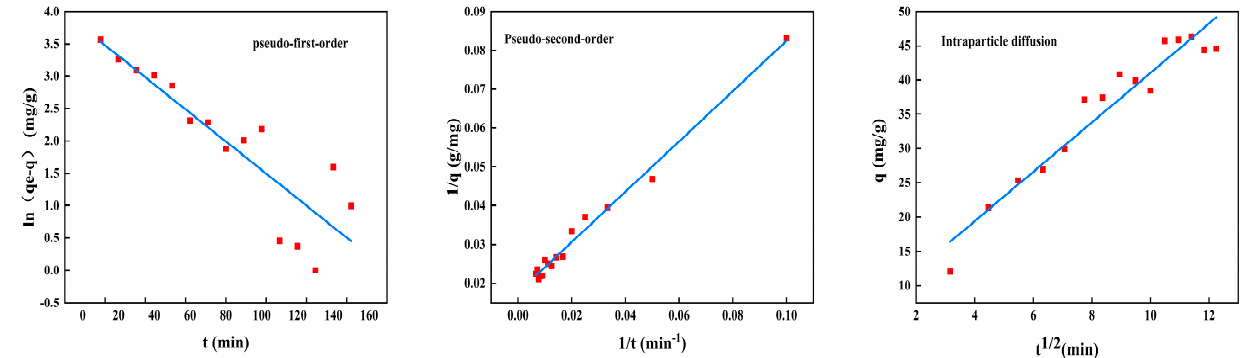
Figure 10. Kinetic adsorption model diagram.